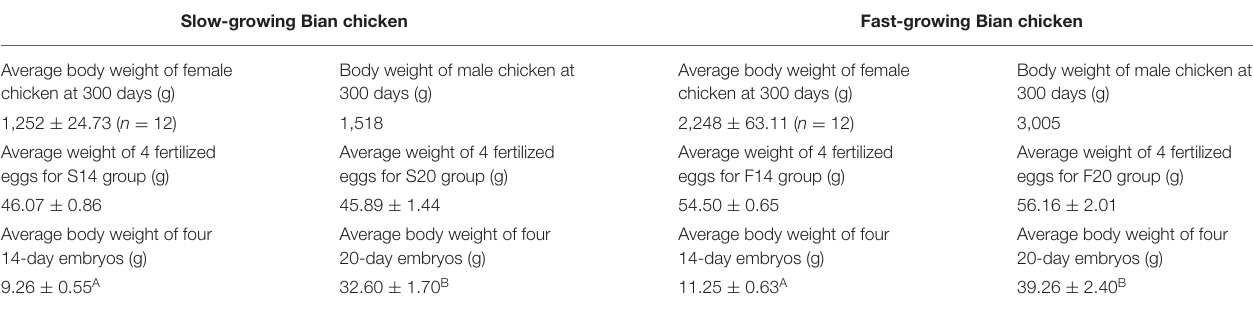
TABLE 1 | Statistics of body weight for fast- and slow-growing Bian chicken. Slow-growing Bian chicken Fast-growing Bian